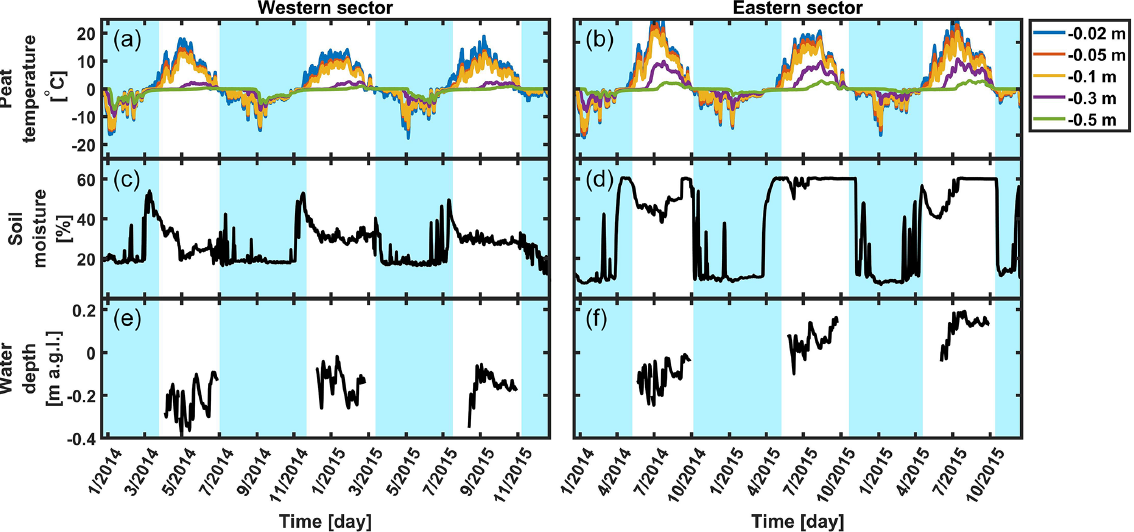
Figure 3. Time series of daily mean values for western and eastern sectors for peat temperature (a, b) , soil moisture (c, d) , and water table level (e, f) , where the shaded light blue area is the frozen period, when peat temperature at 10cm was below 0 ◦ C (see Sect. 2.8 for a detailed description). Table 1. Mean annual air and peat temperatures for the years 2014–2016 for eastern and western sectors. Temperature [ ◦ C] Depth in cm Ambient air